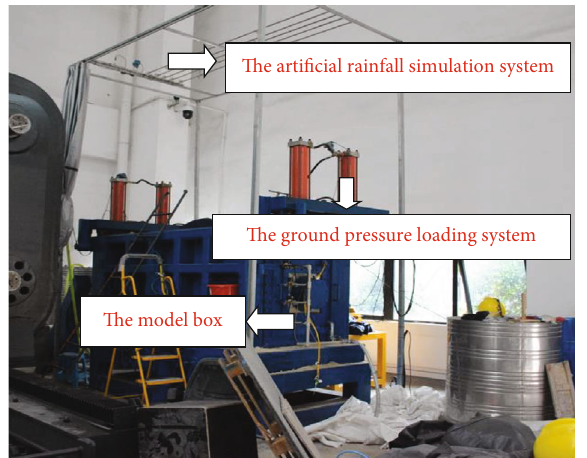
Figure 2: Three-dimensional tunnel model experiment system under rainfall and groundwater seepage